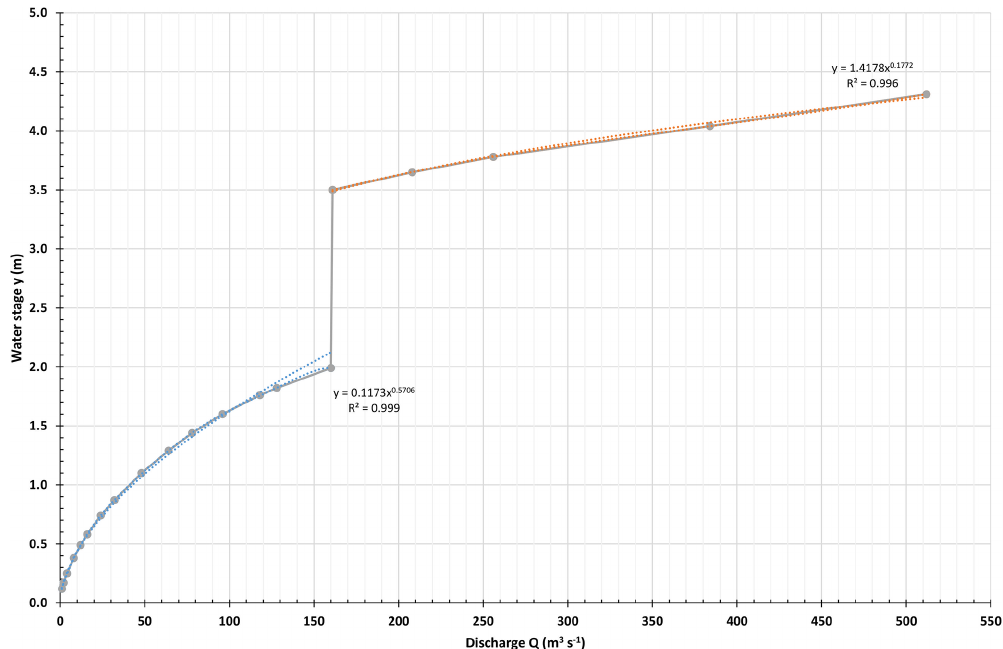
Figure 5. Stage–discharge rating curve performed by means of two-dimensional hydraulic modelling with two differentiated sections in accord with the influence of bridge 1 (see Fig. 3a) and its potential